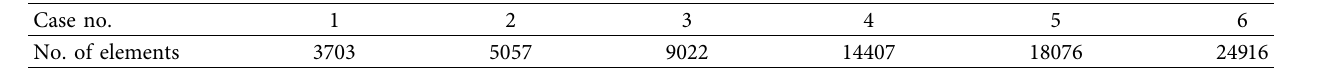
Figure 1: Geometries studied in the present work: (a) circular; (b) octagonal; (c) hexagonal (d) detail A. Table 2: Different solutions to test grid